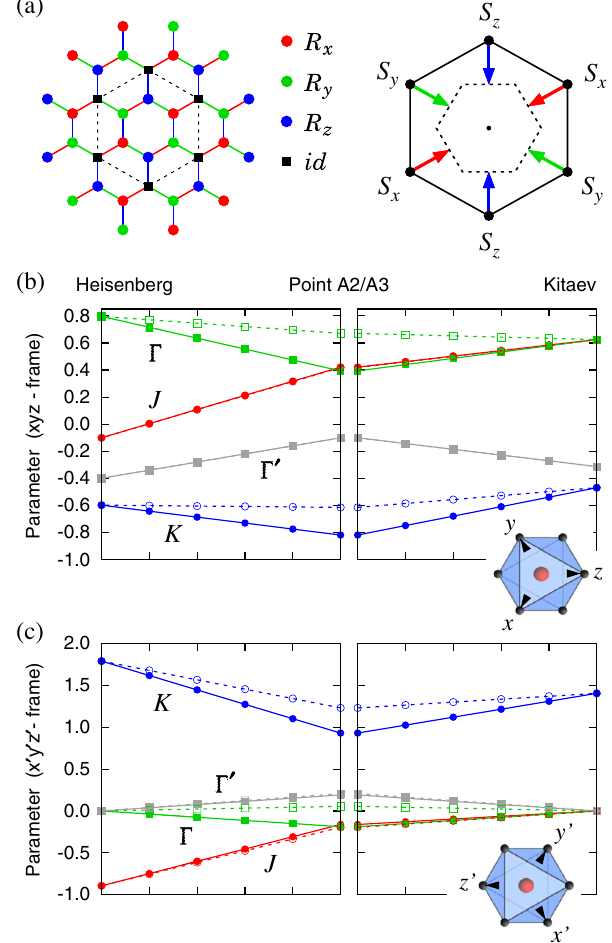
FIG. 9. (a) Four-sublattice transformation used in the text. At the individual sublattices, the spin axes are rotated by 180° around the cubic axes x , y , and z or left intact. In the momentum space (right), the spin components are shifted by the zigzag ordering vectors. (b) Model parameter values along the lines used in Fig. 6. The values are expressed using the original xyz -coordinate system for the spins. The full lines and symbols correspond to Figs. 6(a) and 6(b), and dashed lines and open symbols to Figs. 6(c) and 6(d). The figure is organized like Fig. 6 with A 2 or A 3 parameters being in the middle and the evolution toward the hidden Heisenberg (Kitaev) point corresponding to the left (right) direction from the middle. Only nearest-neighbor interaction parameters JK ΓΓ 0 are presented; J 2 linearly vanish when approaching the points of ; 3 hidden symmetry. The marked parameter points correspond to the spectra shown in Fig. 6. (c) The same lines through the parameter space but expressed using the x 0 y 0 z 0 -coordinate system rotated by 180°aroundtheaxisperpendiculartothehoneycombplane.Inboth xyz and x 0 y 0 z 0 frames depicted by the insets, the axes point above the paper